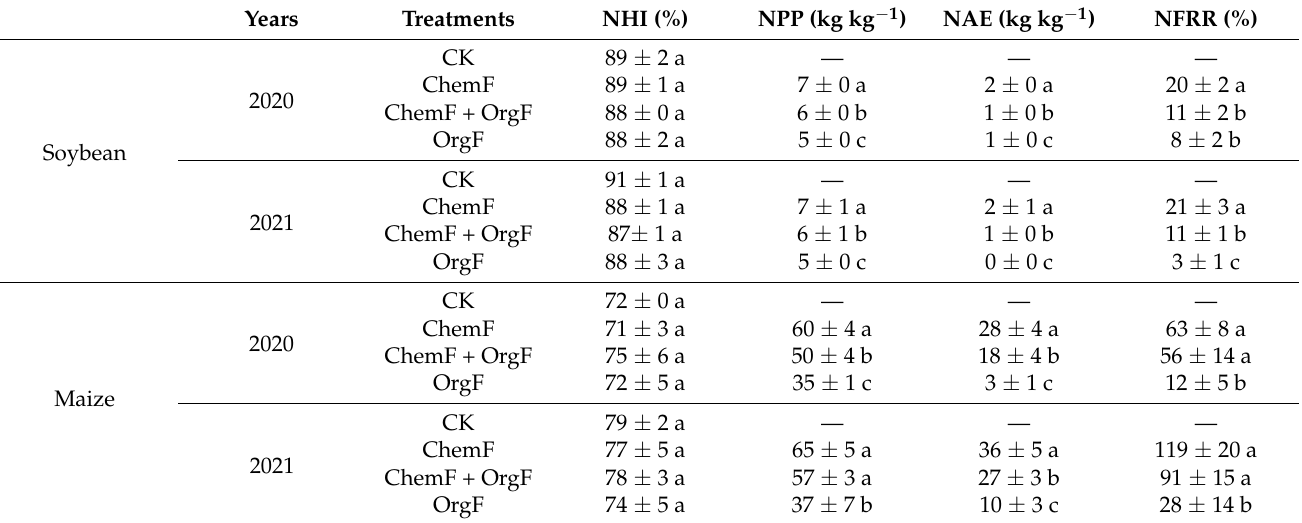
Table 3. Nitrogen harvest index (NHI), nitrogen partial productivity (NPP), nitrogen agronomic